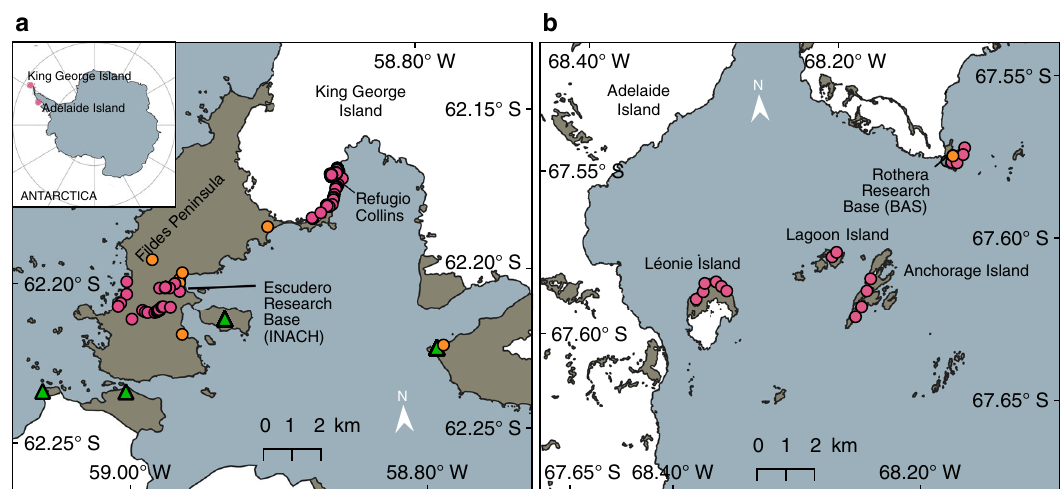
Fig. 6 Ground validation sites. Pink circles show sampling locations from which snow algae hyperspectral hemispherical directional re fl ectance factors (HDRFs) were recorded and algae/snow taken for biogeochemical analysis. Orange circles denote the location of research bases and green triangles denote the location of penguin colonies 55 . a Sampling conducted in the Fildes Peninsula region of King George Island while stationed at Profesor Julio Escudero Base and Refugio Collins in 2019. b Sampling conducted in the Ryder Bay area of Adelaide Island, showing Rothera Research Base and the outlying islands from which snow algae were sampled in 2018. Map data from the SCAR Antarctic Digital Fig. 3a). Images were then converted to 8-bit greyscale and a threshold was applied (default, B&W) so that the cells appear black on a white background. The ‘ despeckle ’ function was used to remove background noise (Supplementary Fig. 3b). The ‘ set scale ’ function was used by tracing the scale bar on the image to additionally determine cell size in μ m 2 . Cells (including any residual extracellular polymeric substances and mineral debris) were automatically counted using the ‘ analyse particles ’ function using a size range of 0 – in fi nity μ m 2 and circularity of 0.00 – 1.00 (Supplementary Fig. 3c). See Supplementary Fig. 3 for ImageJ output. On average, 6% (14% SD) of the cells in the 60 green-dominant samples that were collected during the ground validation at Ryder Bay were visually considered to be red or orange. Hyperspectral HDRFs were convolved to the spectral response of Sentinel 2A and absorption from chlorophyll measured as the scaled area-integral of Band 4 (665nm) relative to Bands 3 (560nm) and 5 (705nm) using Eq. (1) (see Fig. 2 and Supplementary Fig. 2 for visual representations of I B4 .